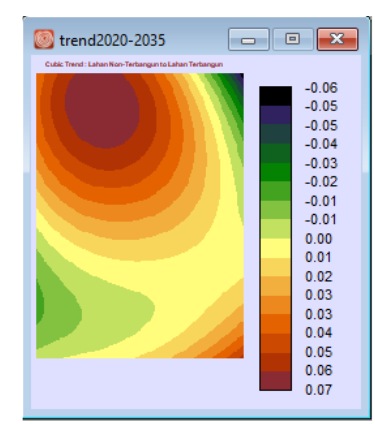
Figure 5. Cubic trend analysis in